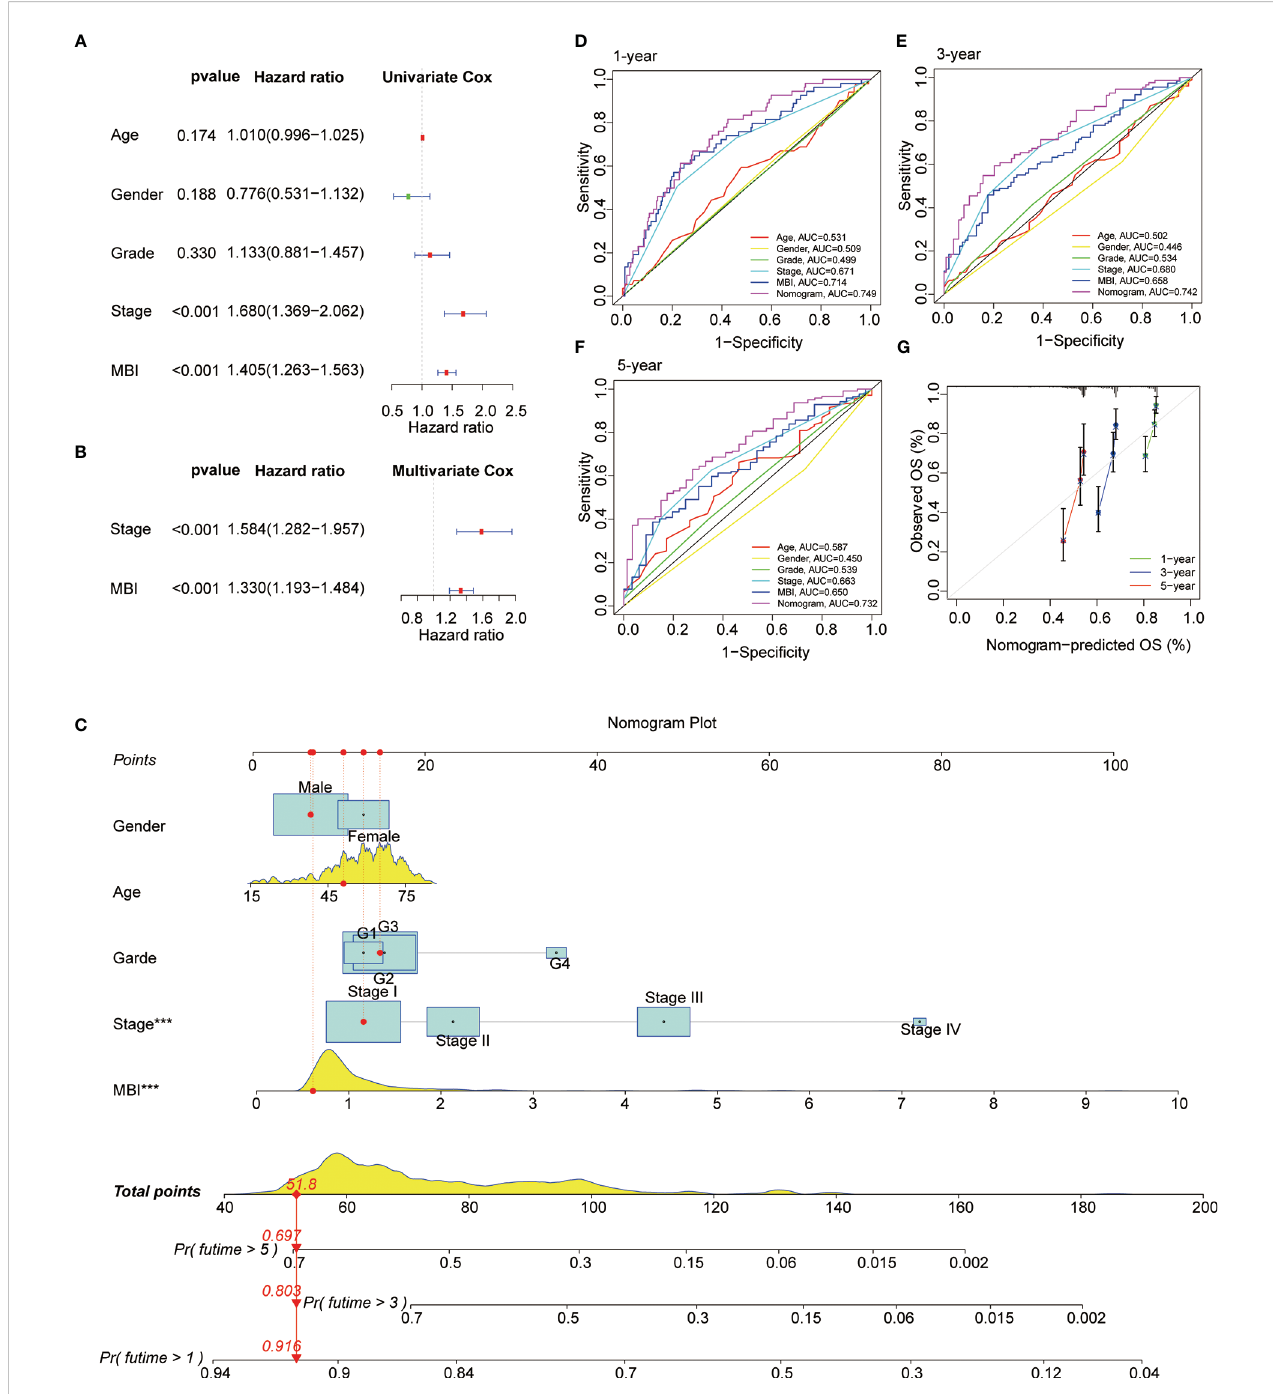
FIGURE 5 Prognostic Value and Clinical Value of MBI. (A) Univariate COX analysis identi fi ed MBI as a risk factor. (B) multivariate COX analysis identi fi ed MBI as a risk factor. (C) The nomogram constructed to predict the probability of patient mortality. (D – F) ROC curves show that both MBI and nomogram scores are good predictors. (G) The calibration curve results found that the model works well. ***P <